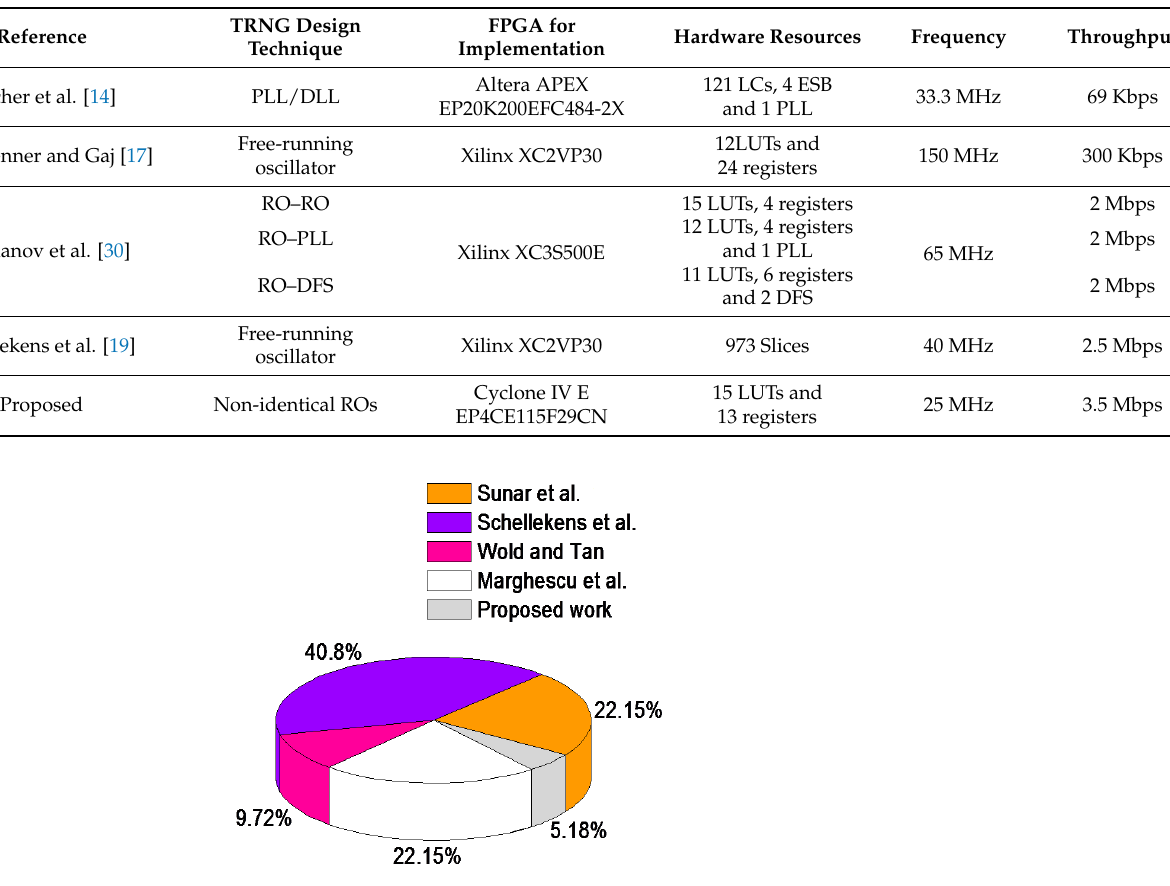
Table 10. Performance comparison: Hardware resources.